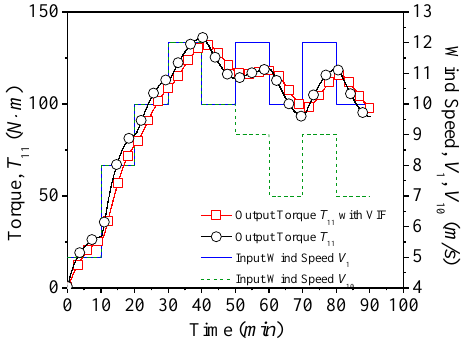
Figure 19. Output rotational speed variation.